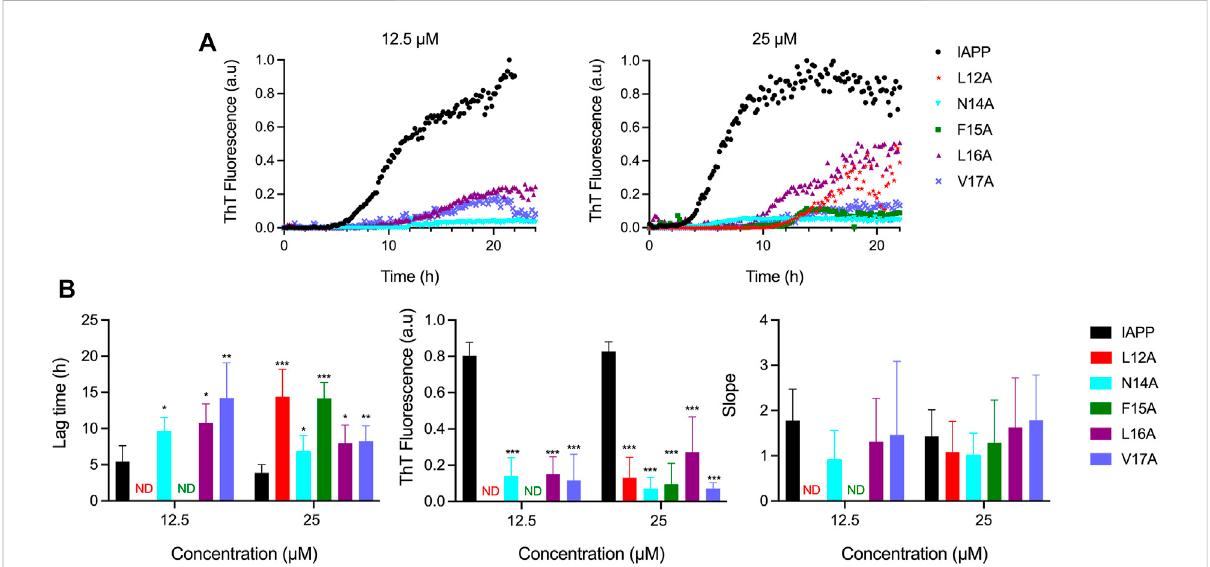
FIGURE 3 Effects of Ala substitution within the 12 – 17 domain on the kinetics of IAPP self-assembly. (A) Representative kinetics of amyloid formation monitoredbyThT fl uorescenceatapeptideconcentrationof12.5and25 μ M.IAPPanditsderivativeswereincubatedin20 mMTris-HCl,pH7.4,and fl uorescence was measured every 10 min. Data obtained from triplicate wells were averaged, corrected by subtracting the vehicle control, and plotted as ThT fl uorescence vs . time (B) Parameters extracted from ThT kinetic traces. Data represent mean ± S.D. of a least six experiments performed in triplicate and signi fi cant difference between IAPP, and analogs was established at (*) p < 0.05; (**) p < 0.005; (***) p <